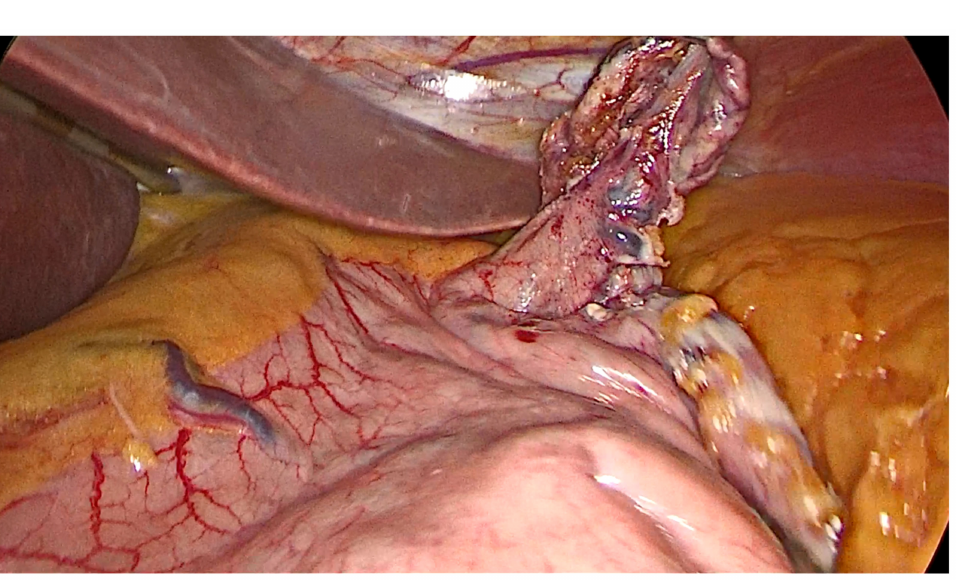
Figure 2. Intraoperative image of the gastric diverticulum after dissection of the greater curvature.